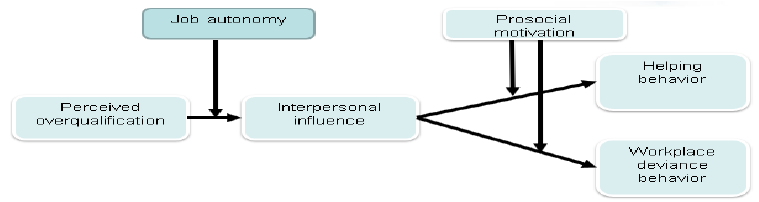
Figure 1: Conceptual Model